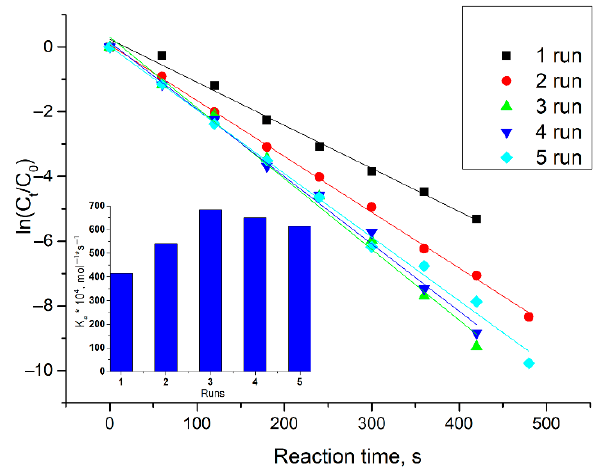
Figure 6. Plots of ln (C t /C 0 ) vs. catalytic reaction time for Pd and polymer catalytic reduction of PNP (5 cycles). C(PNP) = 0.1mM, C(NaBH 4 ) = 5 mM, C(polymer, Pd, = 0.002 mM, H 2 O, 25 °C). Insert: K a values for different catalytic cycles.